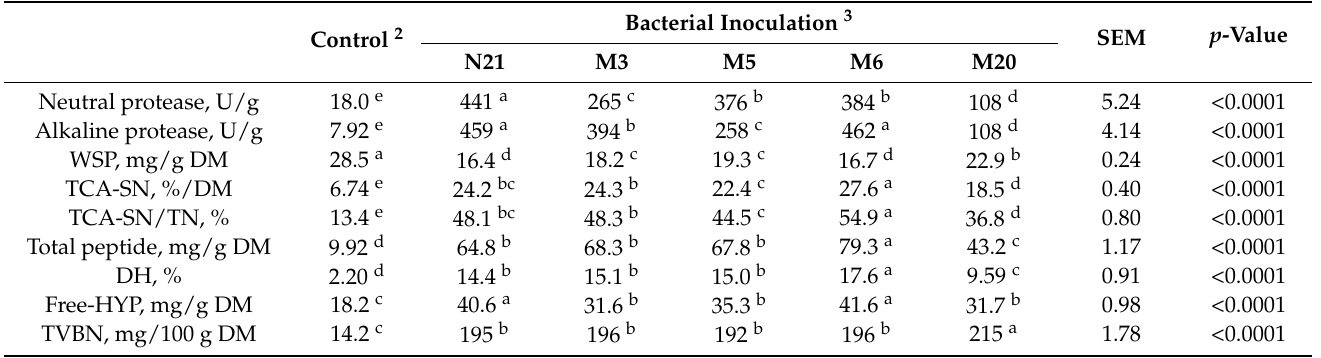
Table 6. Protease activity and protein characteristics of different FMSMPs 1